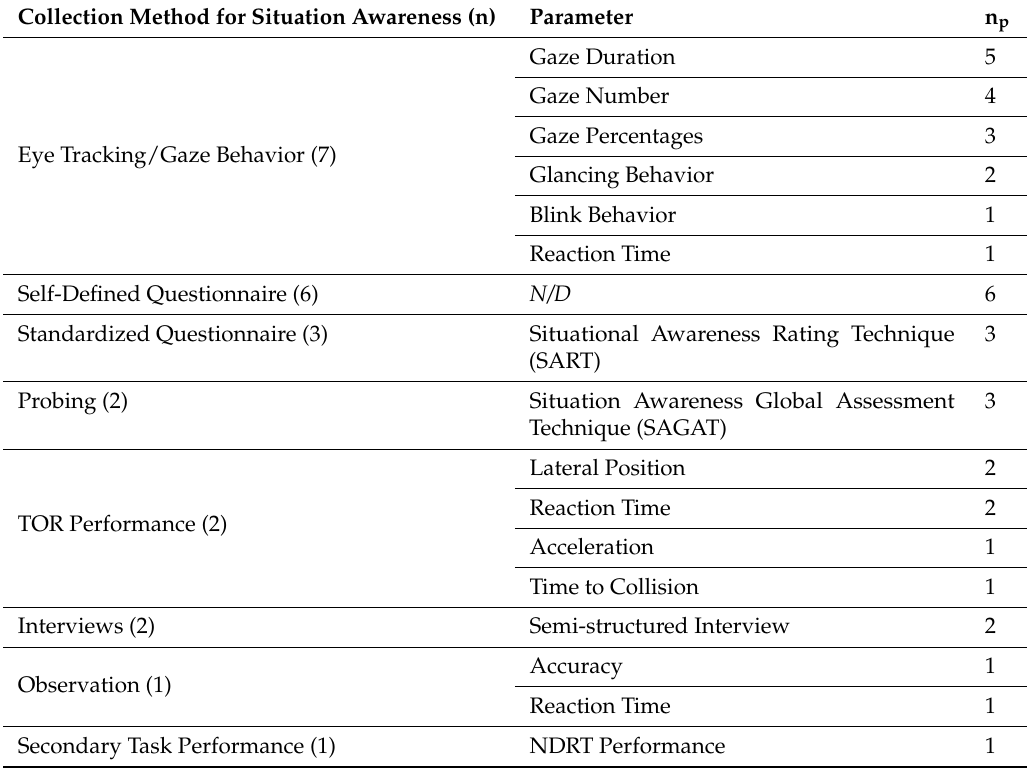
Table 7. Situation Awareness collection methods and